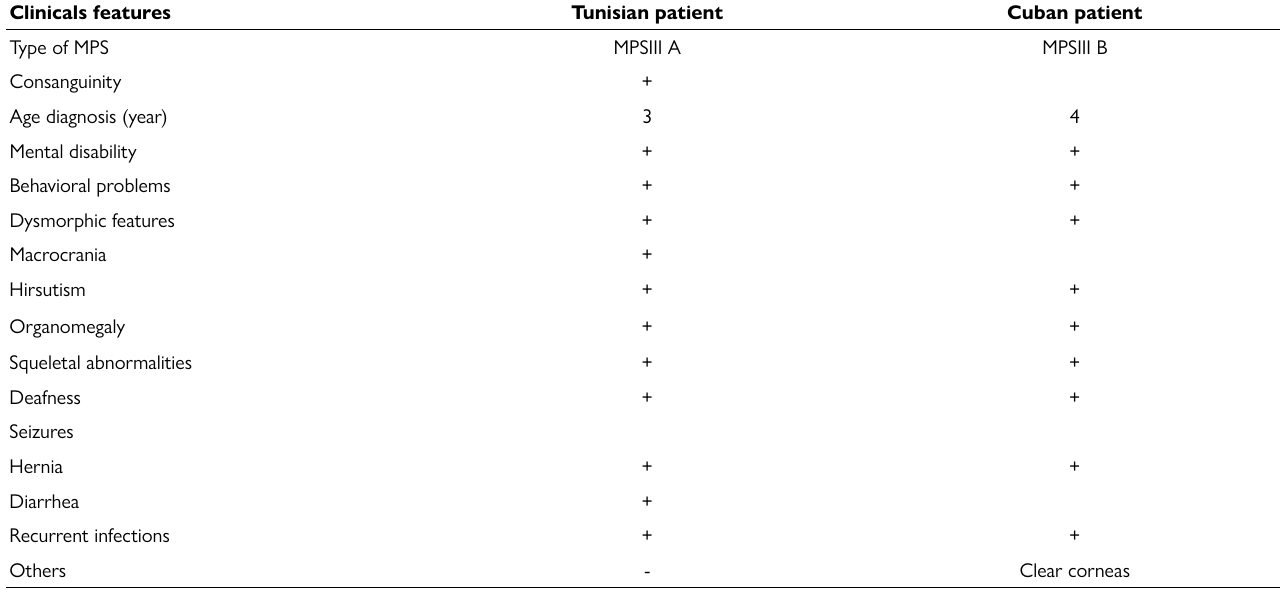
Table 3. Clinical features of a Tunisian and Cuban patients with MPS III. Clinicals